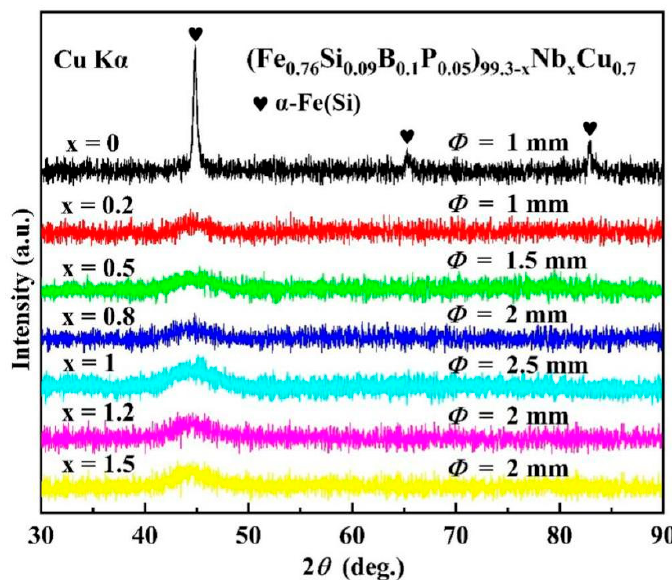
Figure 1. XRD patterns of the as-cast (Fe 0.76 Si 0.09 B 0.1 P 0.05 ) 99.3 − x Nb x Cu 0.7 ( x = 0, 0.2, 0.5, 0.8, 1.0, 1.2, 1.5) rods with different diameters.